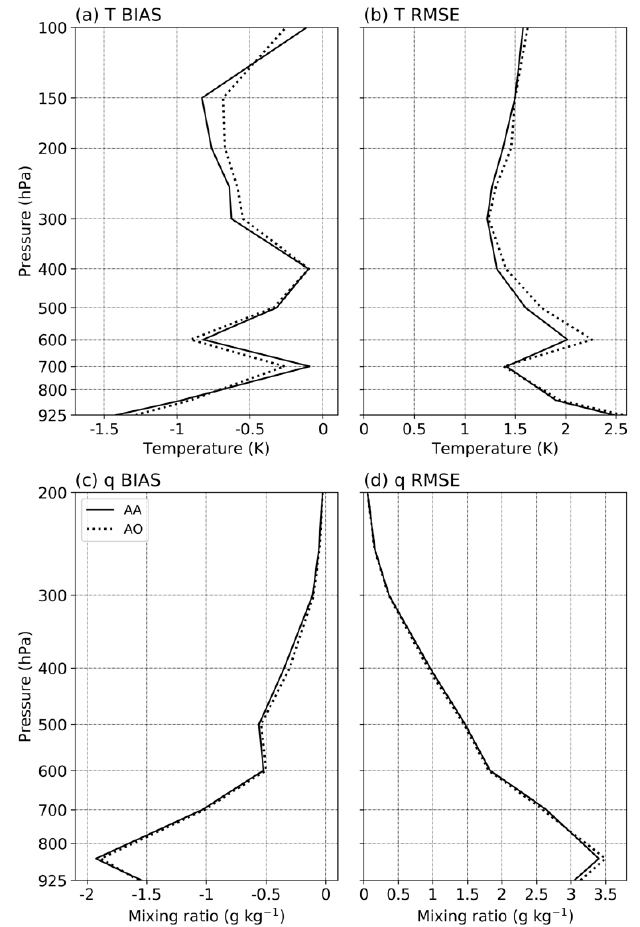
Figure 3. Bias (left column) and root-mean-square errors (RMSE) (right column) for AIRS/AMSU (AA; solid lines) and AIRS-only (AO; dashed lines) data against RAOB measurements, from 20 June to 31 July in the years 2011 to 2016. ( a ) shows bias of T, ( b ) RMSE of T, ( c ) bias of q, and ( d ) RMSE of q. Atmosphere 2019 , 10 , x FOR PEER REVIEW